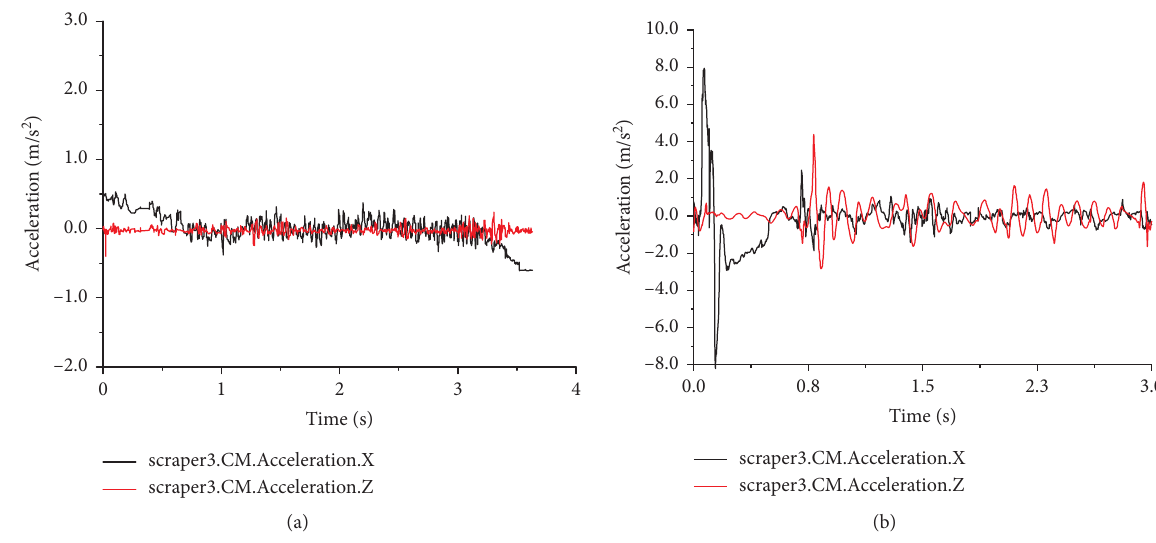
Figure 5: Scraper acceleration comparison. (a) Experimental data. (b) Simulation data.